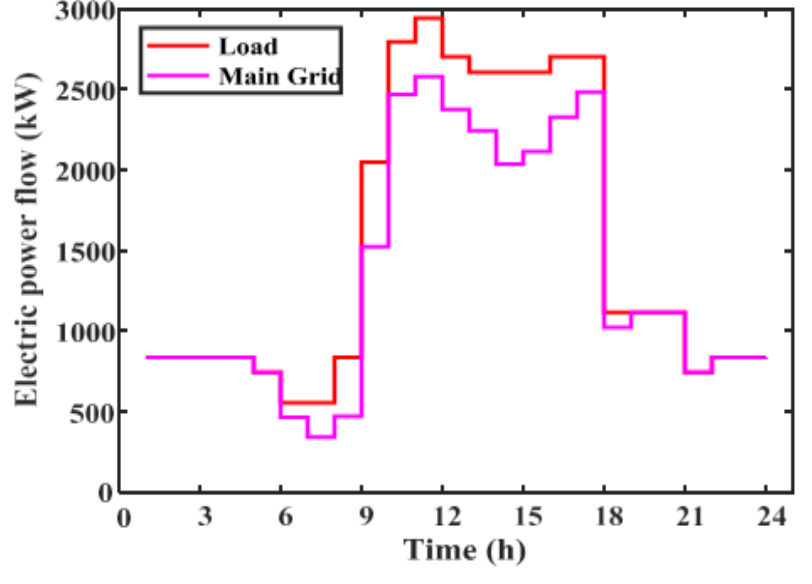
Figure 7. Electrical dispatch with DER.